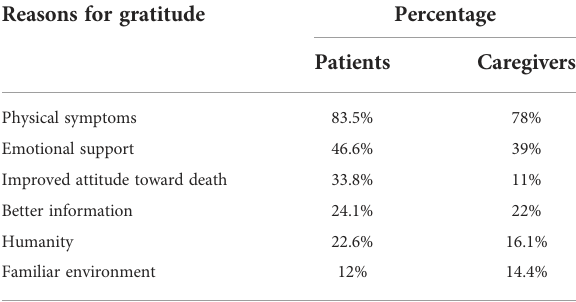
TABLE 4 Emerging reasons for gratitude and illustrative